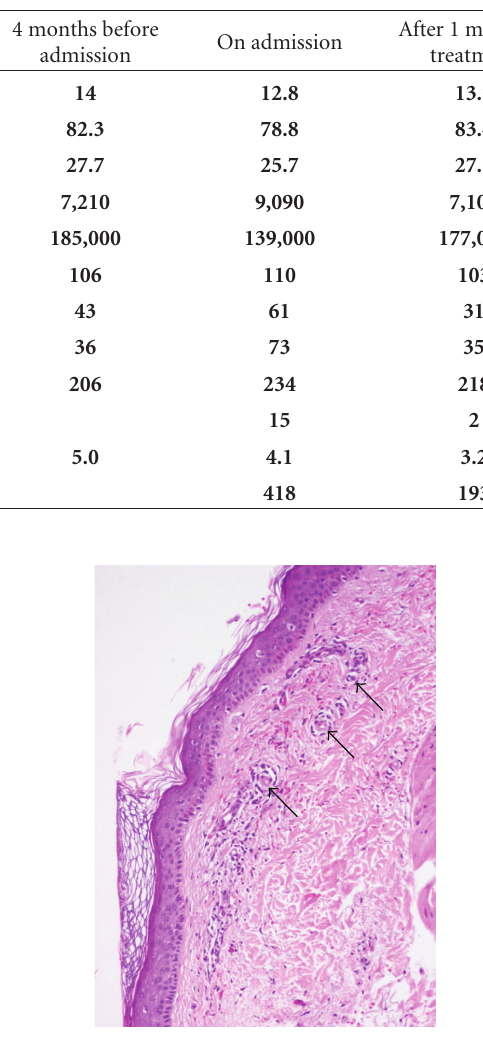
Figure 1: Skin biopsy. Perivascular dermatitis with purpura